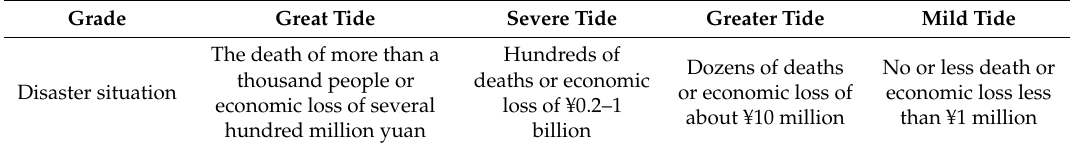
Table 3. Storm surge disaster intensity division based on disaster loss [46].